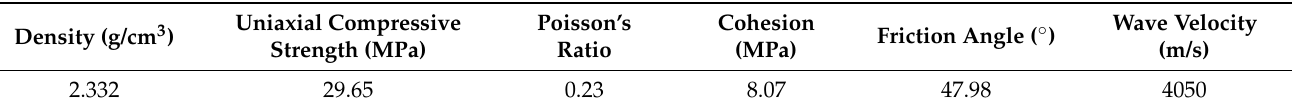
Figure 4. X-diffraction of the rock-like sample.